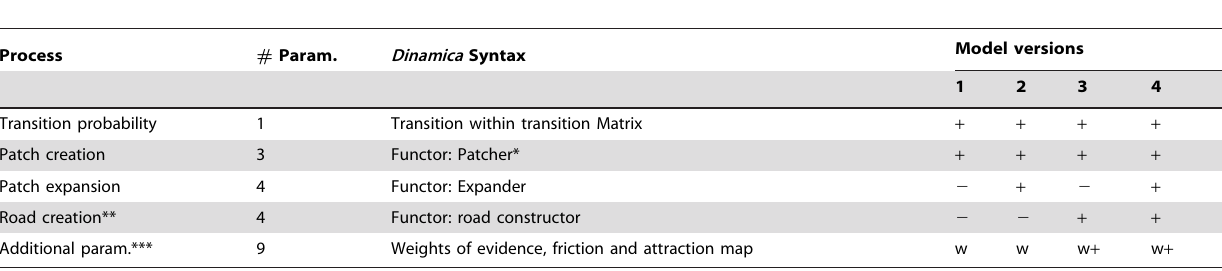
The table delineates the processes included, number of parameters explored ( # Param.), and how these were included in the different model versions of Dinamica . For convenience of replicating these model versions, we provide the syntax for landscape generation. For a full list of parameters and further guidelines see Appendix